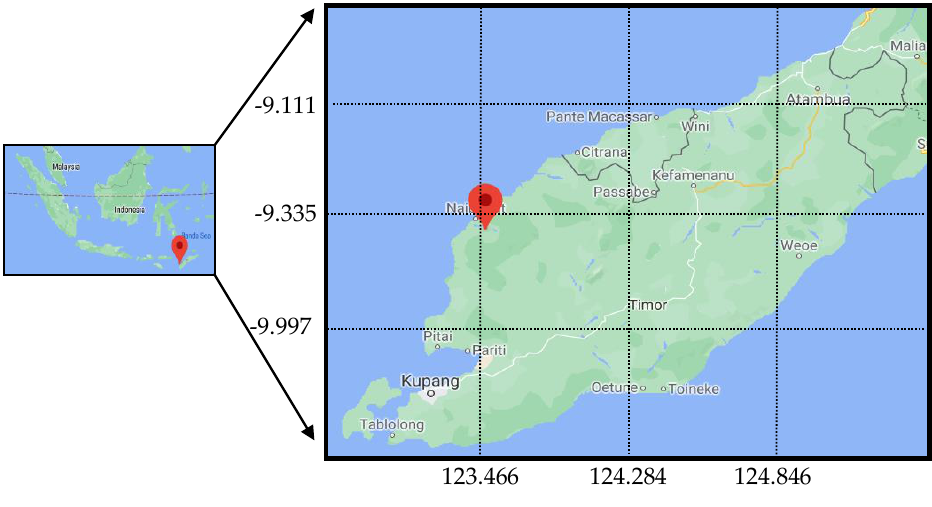
Figure 1. Location of national observatory [8].